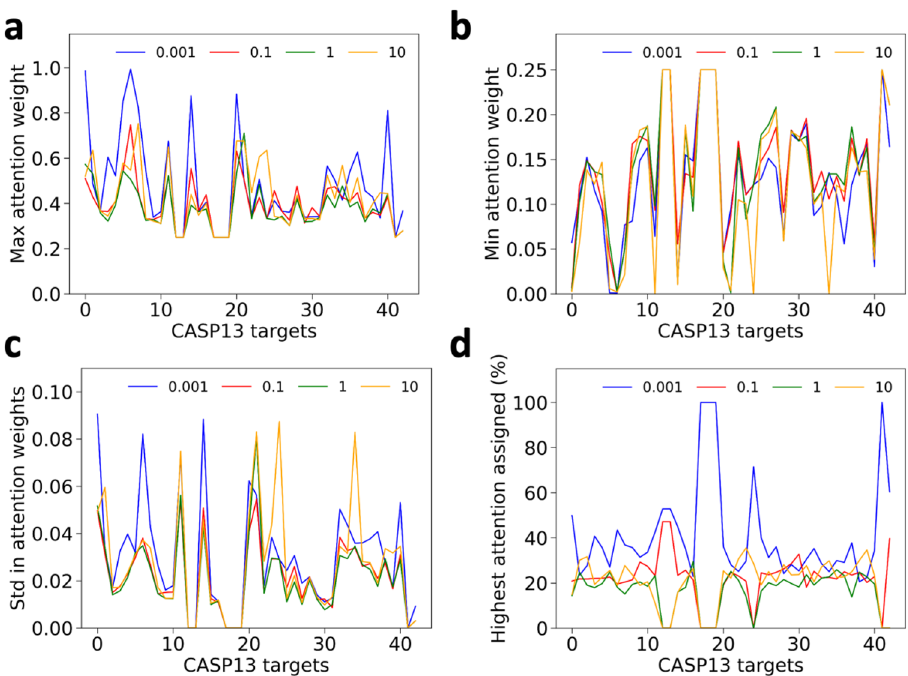
Figure 6. Statistics of pairwise attention weights given to the 43 CASP13 targets. ( a ) the maximum attention weight given to each MSA among values for all the residue pairs. ( b ) the minimum attention weight given to each MSA. c , standard deviation given to each MSA. ( d ) Percentage of residue pairs in a target where each MSA had the largest attention weight. In all figures the x-axis represents the 43 CASP13 targets. Four MSAs with E-value of 0.001, 0.1, 1, and 10 are shown in blue, red, green, and yellow